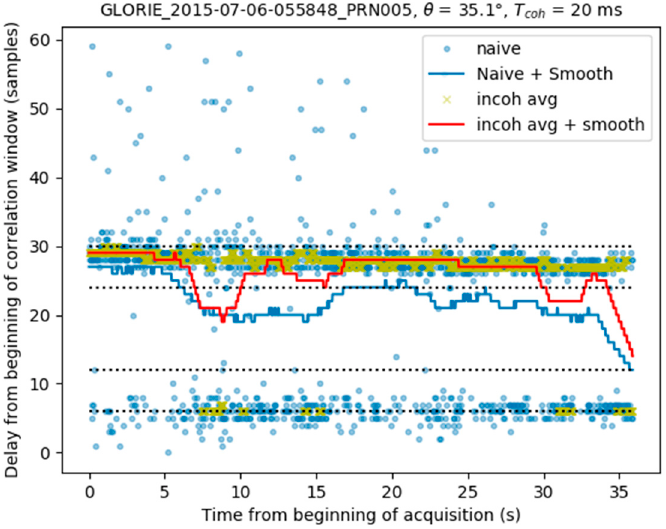
Figure 10. Partitioning of the delay space into three distinct zones, between the min and max values.